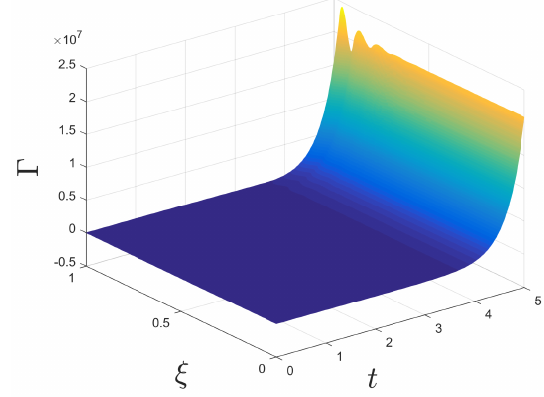
Figure 1. Solution of open-loop system